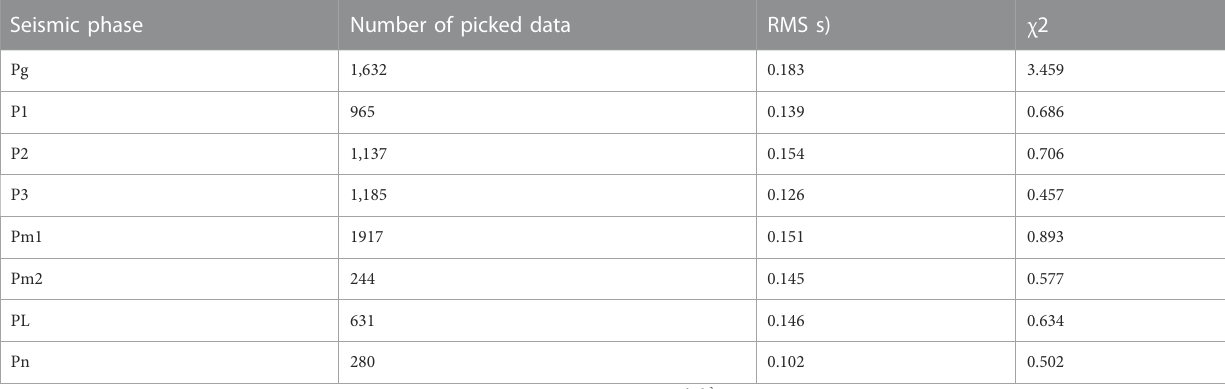
TABLE 2 Ray tracing details for individual seismic phases. Seismic